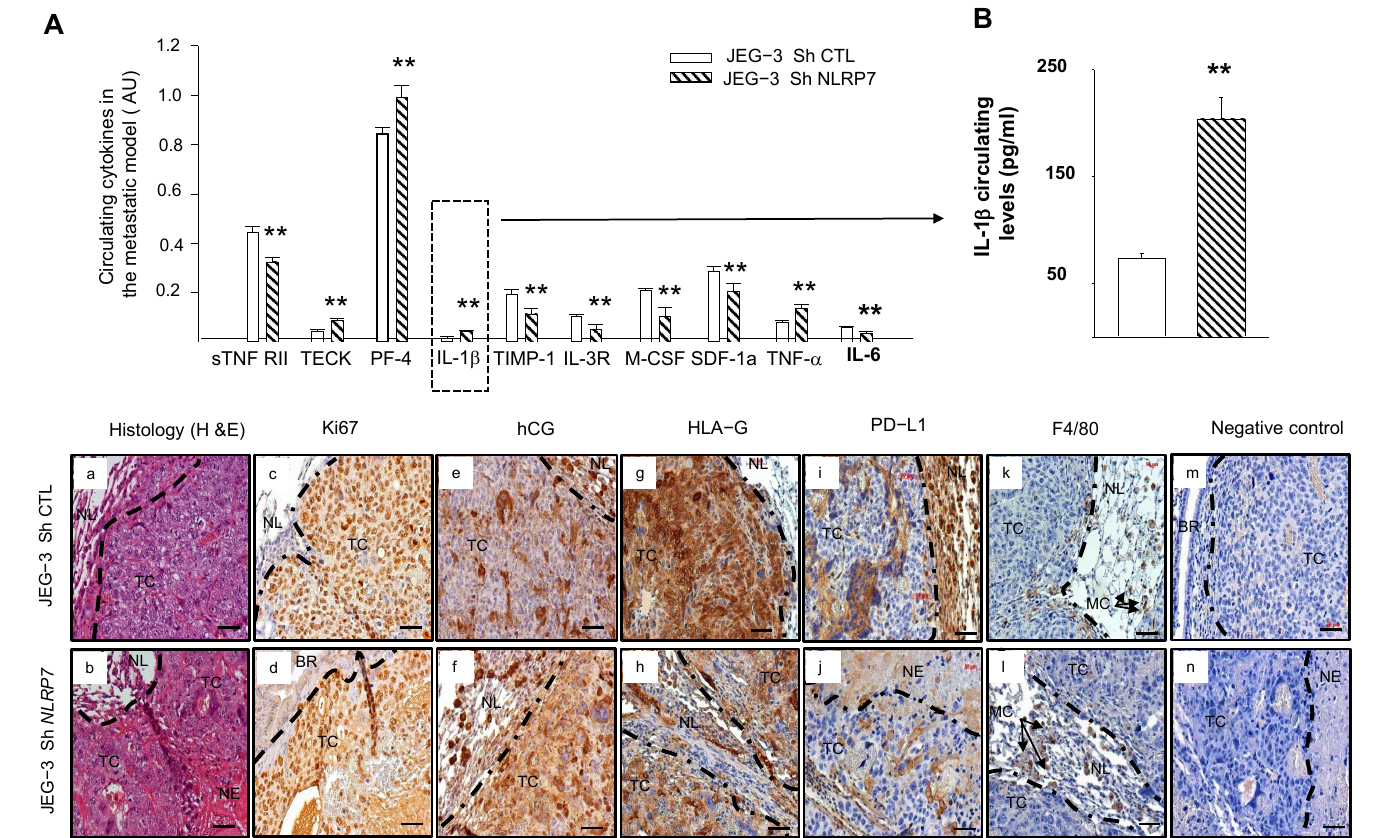
Figure 7. Comparison of the levels of circulating cytokine and immunohistological analyses of the lungs of mice injected with JEG-3 Sh CTL or JEG-3 Sh NLRP7 . ( A ) reports a selection of circulating cytokines that were reported to be significantly differentially secreted on the panel of the 62 cytokines analyzed by antibody array between JEG-3 Sh CTL ( n = 7) and JEG-3 Sh NLRP7 ( n = 7) tail vein injected mice; ** p < 0.01. ( B ) report graphs that compare IL − 1 β circulating levels in the metastatic animal model. ELISA test was used to compare these levels ( n = 7 each); ** p < 0.01. ( C ) reports representative images of lung sections collected from JEG-3 Sh CTL and JEG-3 Sh NLRP7 injected mice. Images in ( Ca , b ) report the histology of the lungs. The subsequent sections report stainings for the following proteins, Ki67 ( Cc , d ); hCG ( Ce , f ); HLA-G; ( Cg , h ); PDL-1 ( Ci , j ) and F4/80 ( Ck , l ). Images in ( Cm , n ) represent negative controls that were incubated without the primary antibodies. TC: tumor cells, NL: Normal Lung, BR: Bronchus, MC: Macrophages, NE: Necrosis. Scale bar = 50 µ